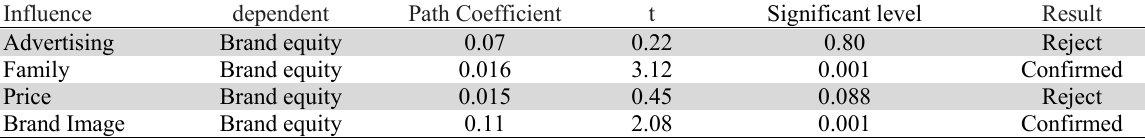
The summary of testing the effect between factors affecting brand equity Influence dependent Path Coefficient t